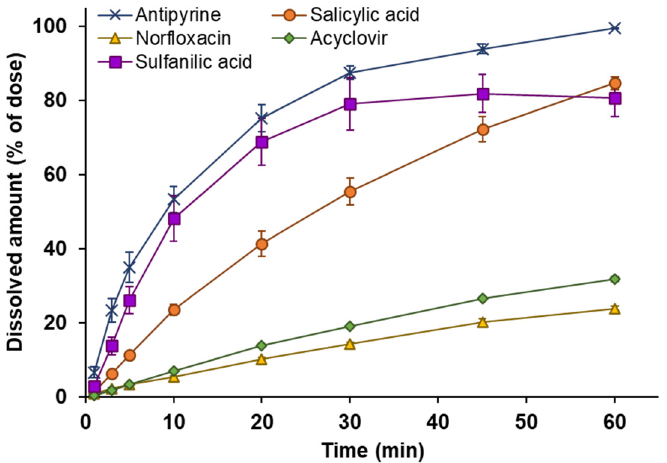
Figure 2. Time profiles of drug dissolution from powder formulation into ANF for five model drugs, antipyrine ( × ), salicylic acid ( • ), norfloxacin ( ▲ ), acyclovir ( ◆ ), and sulfanilic acid ( ■ ). Powder (10% API in lactose, 10 mg) was applied to the ANF. The data are represented as the mean of independent experiments, with the vertical bars indicating the S.E. (n = 3–5).